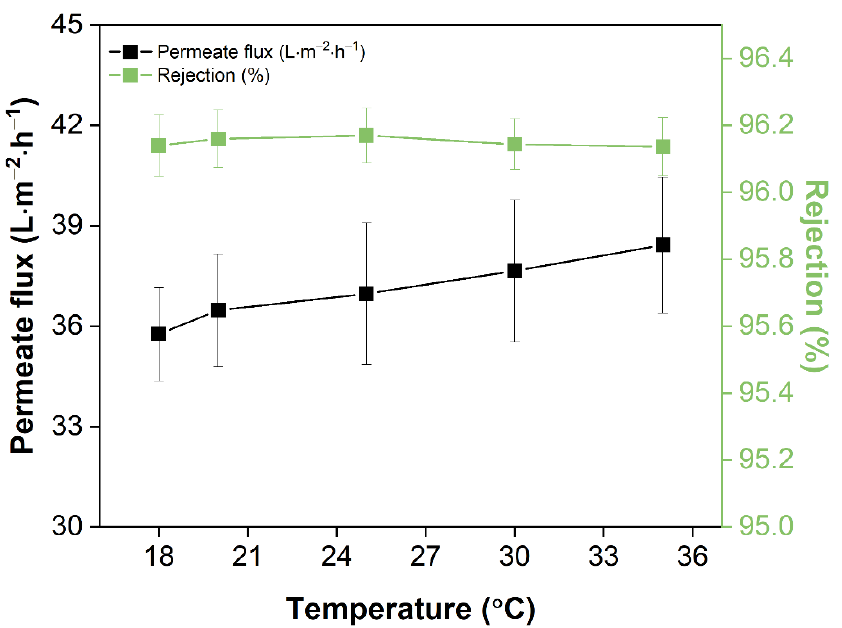
Figure 5. Permeate flux (black dot line) and rejection (green dot line) of RO membrane after 10 h running under different temperatures from 18 to 35 °C. Operating conditions: feed solution, Na 2 SO 4 ; feed concentration, 2500 mg·L −1 ; feed flow rate, 35 L·h −1 ; operating pressure, 0.5 MPa; pH, 7.